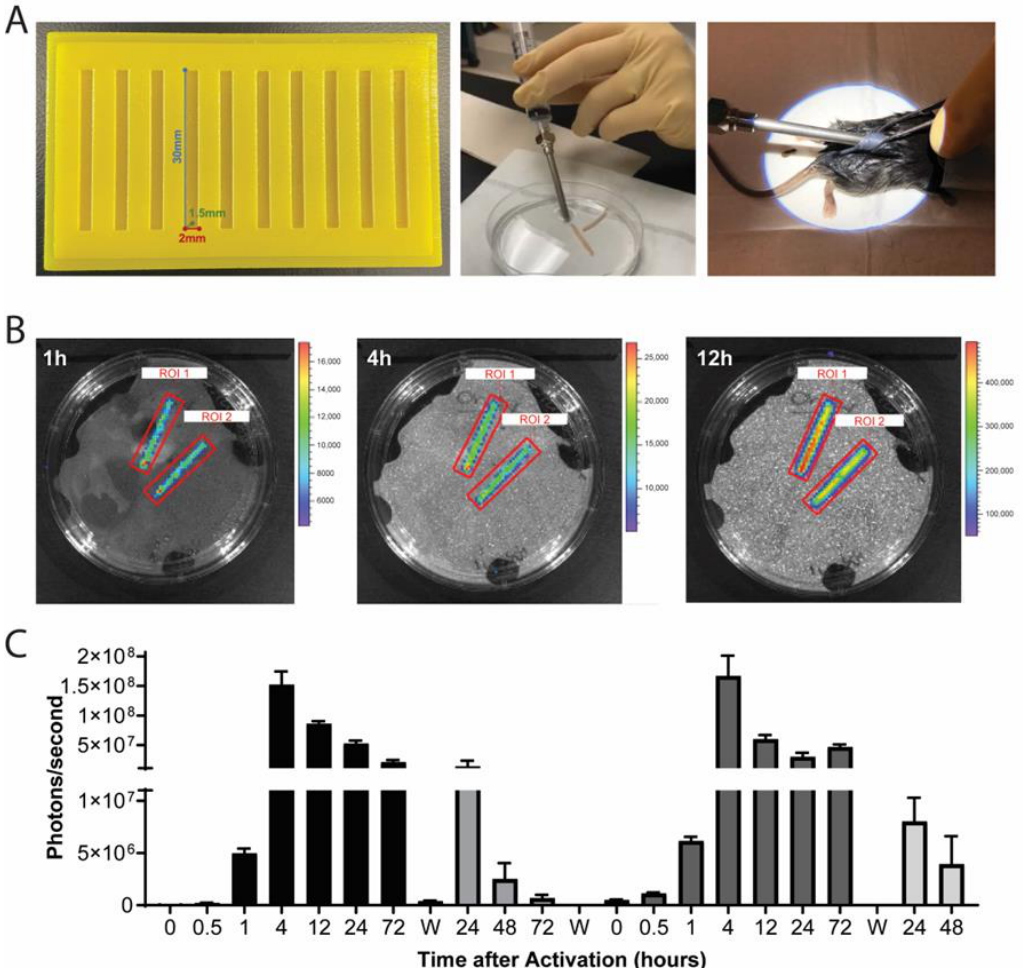
structs, which were aspirated into a wide-bore needle (middle) for minimally-invasive implantation subcutaneously through a small dorsal incision (right). ( B ) Ccl2-luc agarose rod constructs were challenged with 1 ng/mL IL-1 α imaged via IVIS to observe activation over time, shown here is a time course of the same two constructs at 1 h, 4 h, and 12 h post IL-1 α challenge. ( C ) Constructs showed robust activation with repeated washout (designated “W”) and reactivation with 1 ng/mL IL-1 α . n = 2–6